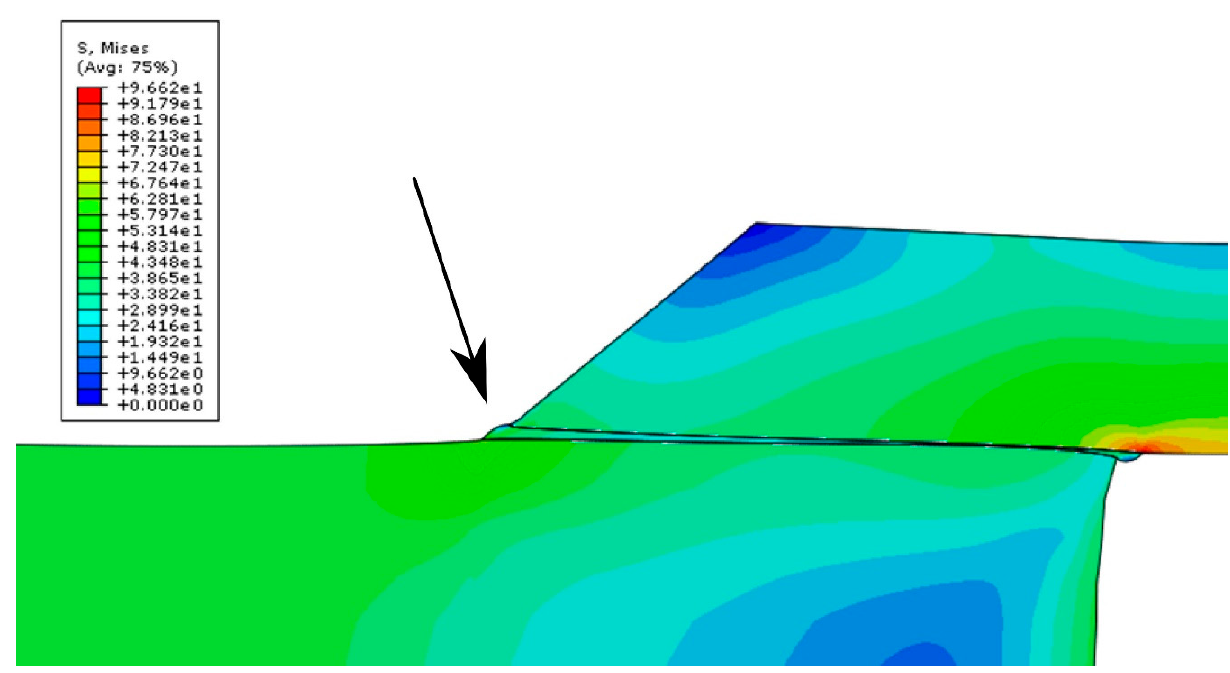
Figure 4. Stress bitmap shown on the 1/4 part of the FEM model. Representation of displacements with a deformation factor ×150.